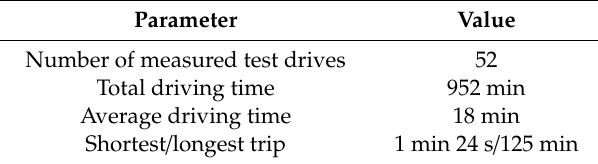
Table 2. Overview of all measured test drives, NEmo 08 / 2018 to 02 /